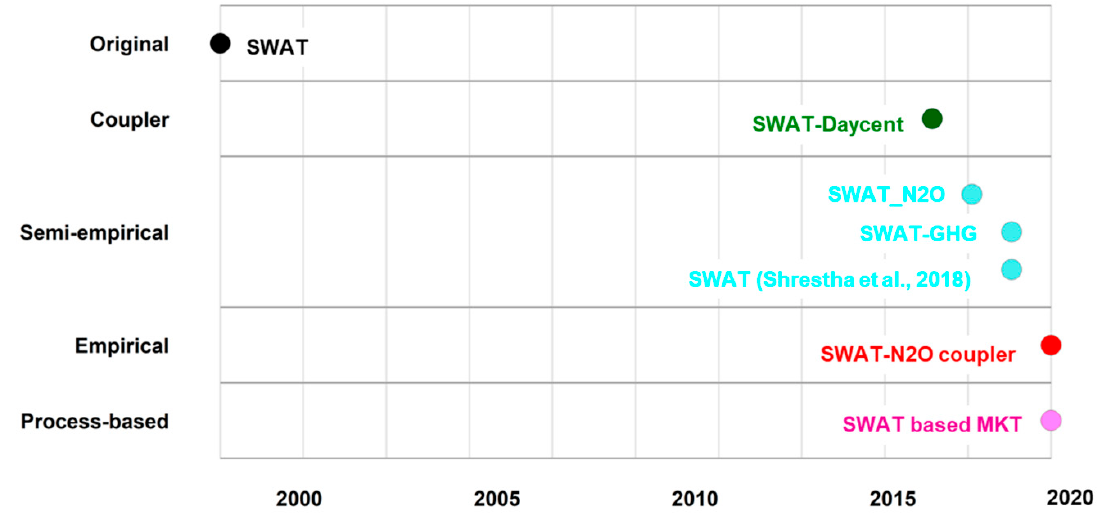
Figure 3. Development history of N 2 O emission modules with SWAT.